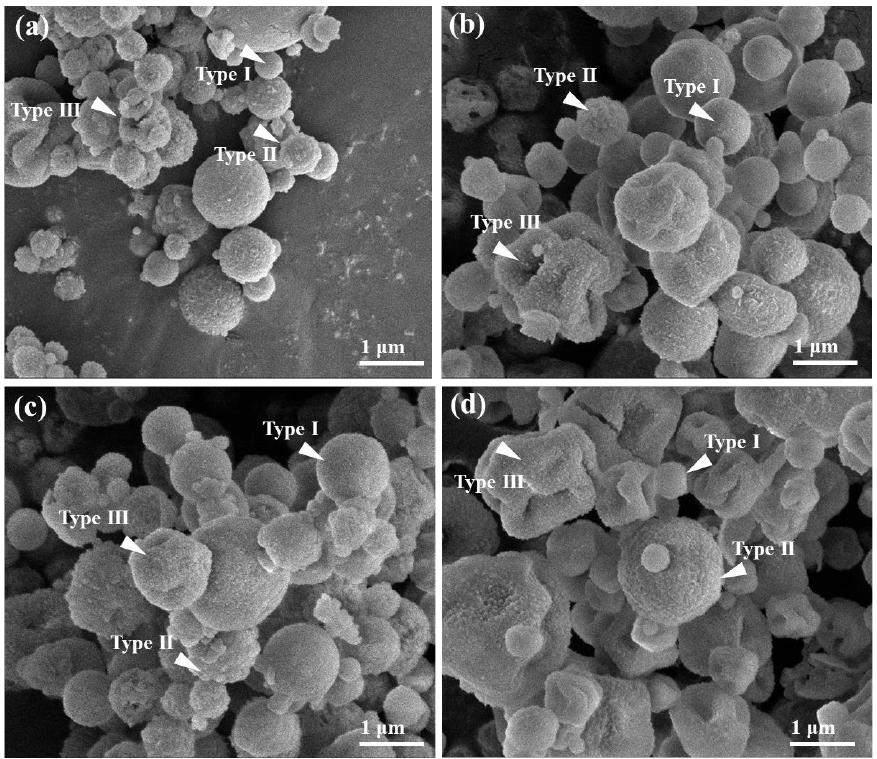
Figure 2. SEM micrographs of Mg 2 SiO 4 -calcined powders at ( a ) 850, ( b ) 900, ( c ) 950, and ( d ) 1000 °C. The various morphological types are highlighted with triangles.